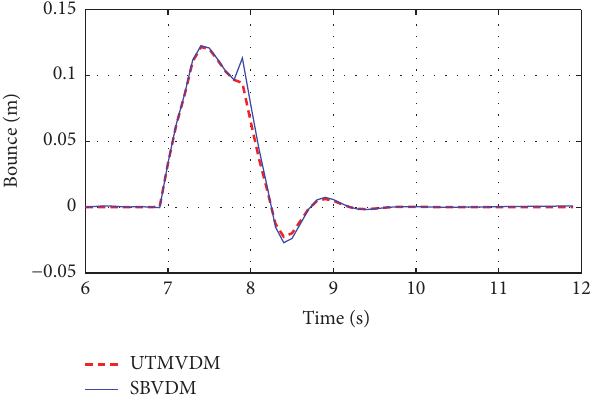
Figure 19: Bounce displacement when passing a bump.